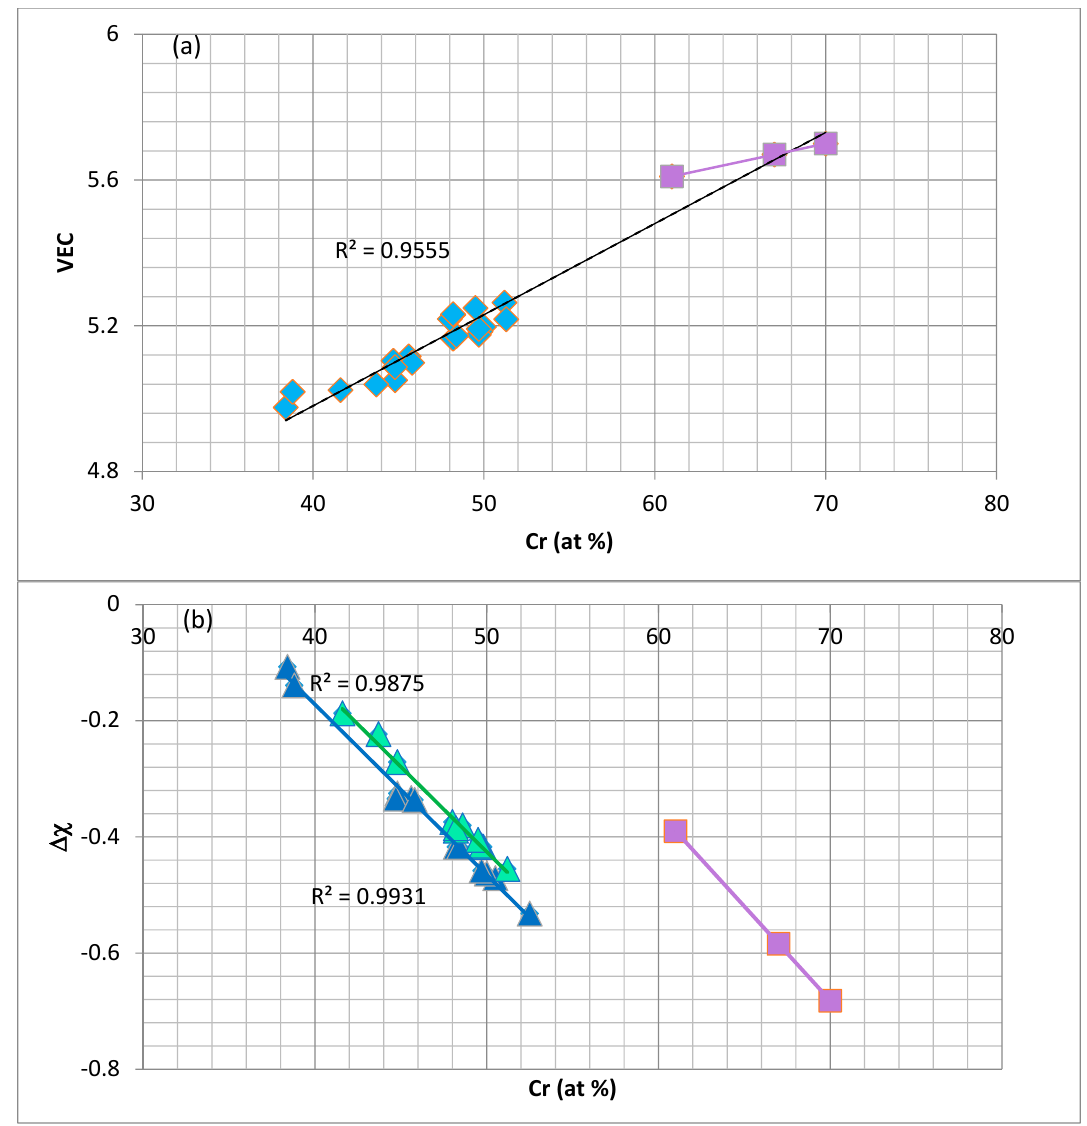
Figure 1. Valence electron concentrations (VEC) ( a ) and ∆χ ( b ) versus the Cr concentration in the C14 NbCr 2 Laves phases. The squares represent the unalloyed NbCr 2 . In ( a ) the blue diamonds correspond to the same data as in ( b ). In ( b ), the data can be separated: the blue triangles represent Laves phases where Nb is substituted by Ti, Mo or Hf, and Cr is substituted by Si, Sn or Al, and the green triangles represent Nb, substituted by Ti and Hf, and Cr by Si, Al, Ge or Sn.